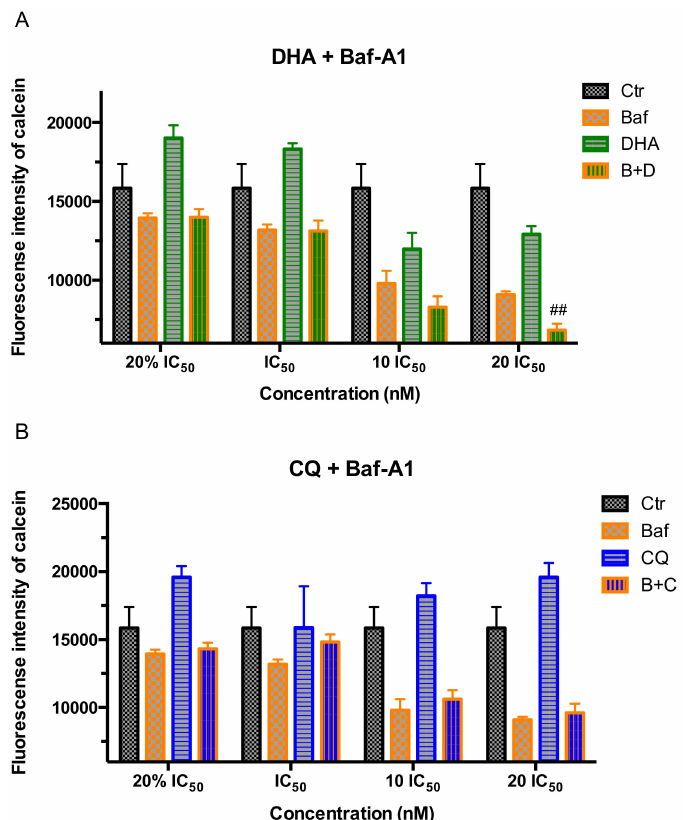
Figure 7. The fluorescence intensity of parasites in trophozoite stage P. f 3D7 staining with pH probe Calcein, AM after 2 h of combination drug treatment with a series dose of antimalarial drugs DHA / CQ and V-ATPase inhibitor Baf-A1 by flow cytometry. ( A ) Fluorescence intensity of BCECF in trophozoite stage P. f 3D7 treated by DHA combined with Baf-A1; ( B ) Fluorescence intensity of BCECF in trophozoite stage P. f 3D7 treated by CQ combined with Baf-A1. Ctr means control, B + D